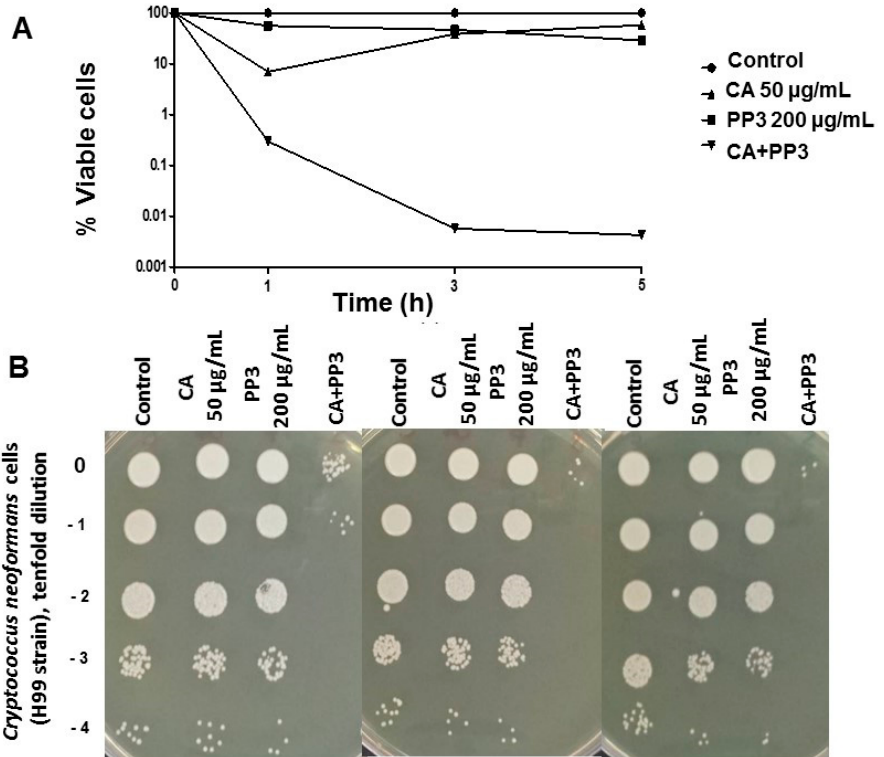
Figure 3. Time-course evolution of cell viability (%) after the addition of 50 µ g/mL CA and 200 µ g/mL PP3, either separately or in a mixture, to cultures of C. neoformans H99 growing on YPD. Exponential cells were aliquoted and treated for 1, 3, and 5 h at 37 ◦ C with the indicated concentrations of CA and PP3. After incubation, identical samples were harvested, washed, and the percentage of surviving cells determined in liquid medium by CFU counting ( A ). The macroscopic colonial growth in the tested conditions was also recorded by spotting tenfold serial dilutions onto YPD plates and was further incubated at 37 ◦ C for 24 h ( B ). The data shown are representative of three independent experiments. Statistically significant differences with respect to an untreated control were tested using the Mann–Whitney U test.